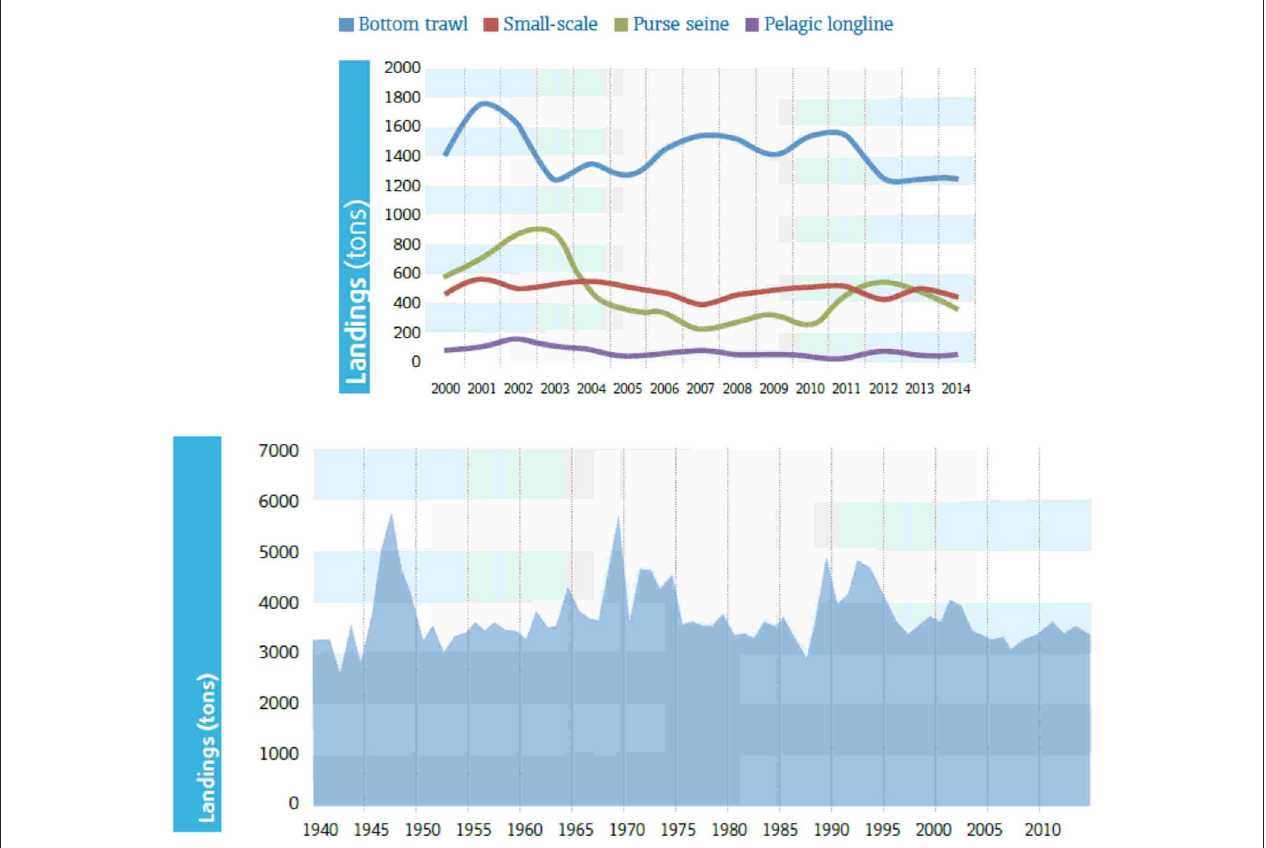
FIGURE 2 | Landings of the main fishing fleets from Mallorca between 2000 and 2014 (above) and total landings from the Balearic Islands during the last 75 years